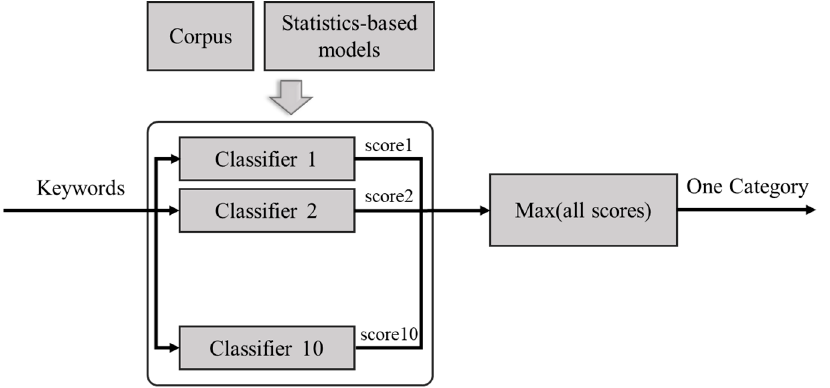
Figure 3. SVM-based multiclass classifier.